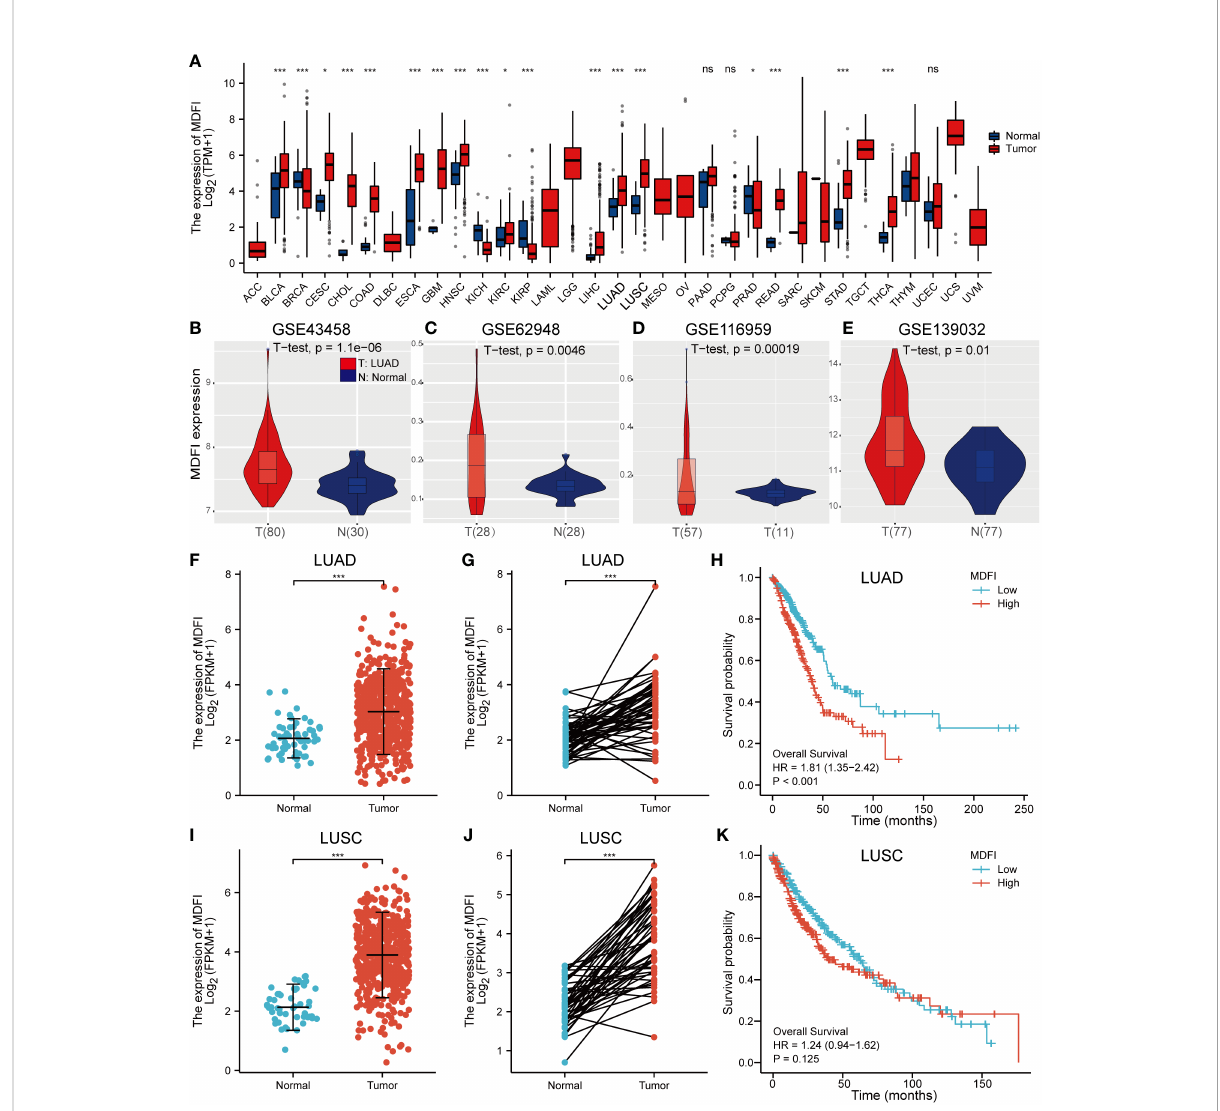
FIGURE 1 Analysis of MDFI expression in tumors, (A) Pan-cancer analysis of MDFI, (B – E) Expression analysis of MDFI in 4 sets of GEO datasets, (F) Expression analysis of MDFI in unpaired samples of LUAD, (G) MDFI in the LUAD expression analysis in paired sample, (H) Prognostic analysis of the survival of MDFI in LUAD, (I – K) Expression analysis of MDFI in LUSC. (A, F – K) Data from TCGA database. *p < 0.05, ***p < 0.001. ns, no signi fi